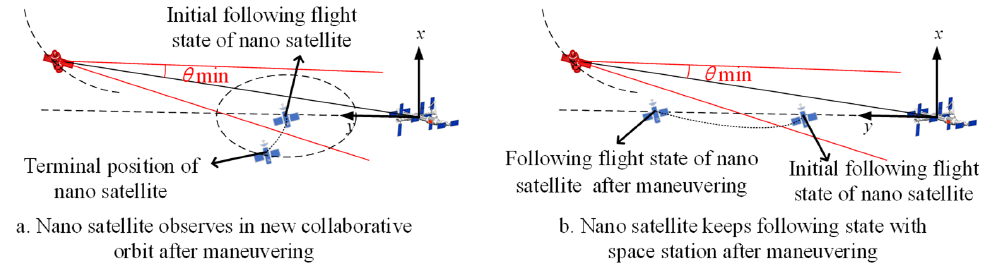
Figure 6. Scenario 3: Nano-satellite keeps following flight with the space station at the initial time.